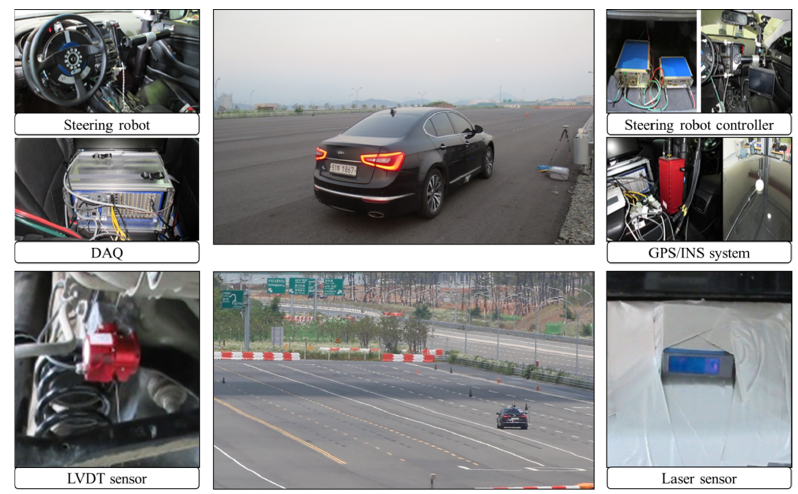
Figure 11. Test vehicle and equipped sensors.